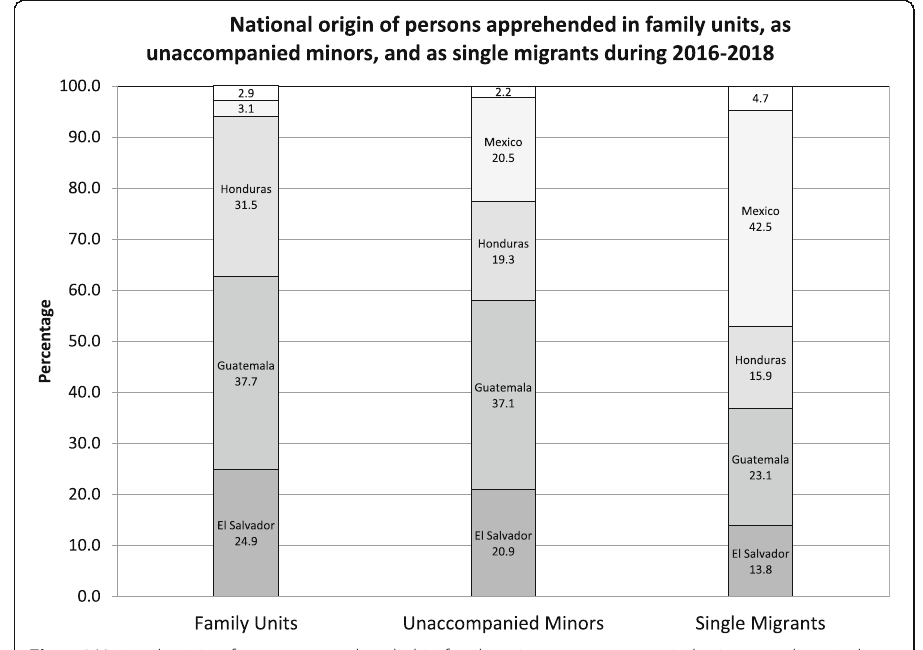
Fig. 16 National origin of persons apprehended in family units, as unaccompanied minors, and as single migrants during 2016 –